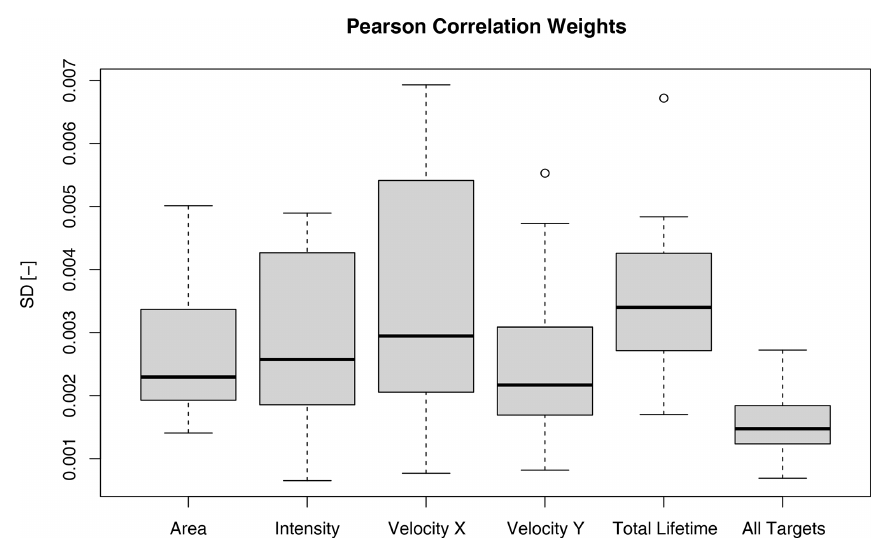
Figure A1. The standard deviation of the Pearson correlation weights between predictors and target variables obtained from a cross-sampling of the events (leave one event at a time out). The box plot for each target variable describes the spread of the standard deviation over all selected